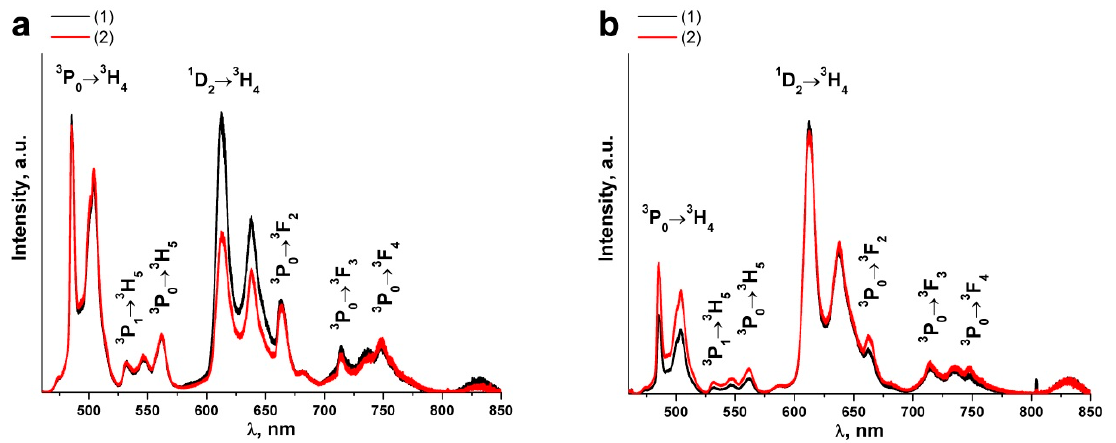
Figure 5. Luminescence spectra of Pr 3+ ions in the crystals: ( a ) (ZrO 2 ) 0.805 (Y 2 O 3 ) 0.188 (Pr 2 O 3 ) 0.007 ; ( b ) (ZrO 2 ) 0.802 (Y 2 O 3 ) 0.195 (Pr 2 O 3 ) 0.003 ; (1) beginning of crystal and (2) end of crystal, λ exc. = 457 nm, T = 300 K.